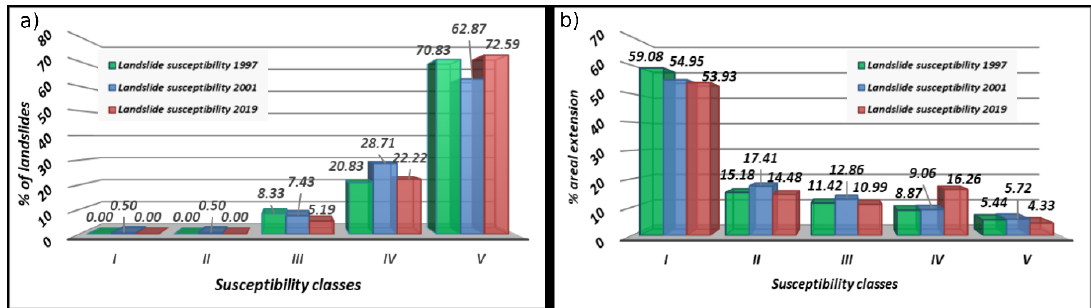
Figure 8. ( a ) Landslide susceptibility distribution of wildfires area in the different classes; ( b ) areal extension distribution of susceptibility maps of the wildfire area for each susceptibility level.